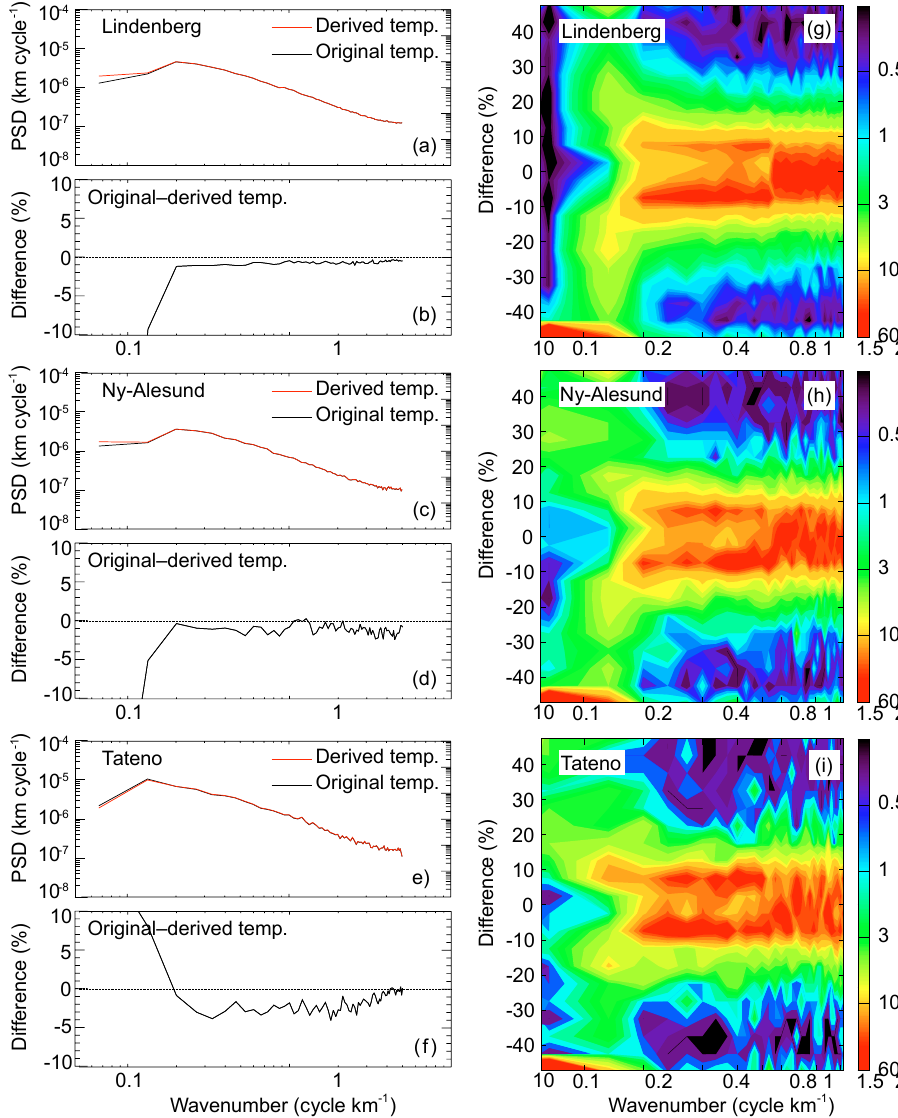
Figure 4. Power spectra density (PDS) of normalized temperature perturbations (a, c, e) and their differences (b, d, f) for radiosonde- measured and derived temperature profiles at the stations Lindenberg, Ny-Alesund, and Tateno. Distributions of the PSD differences between the radiosondes and derived profiles are shown in panels (g–i) ; the color scale represents the number of profiles falling into a specific interval of perturbation differences and wave